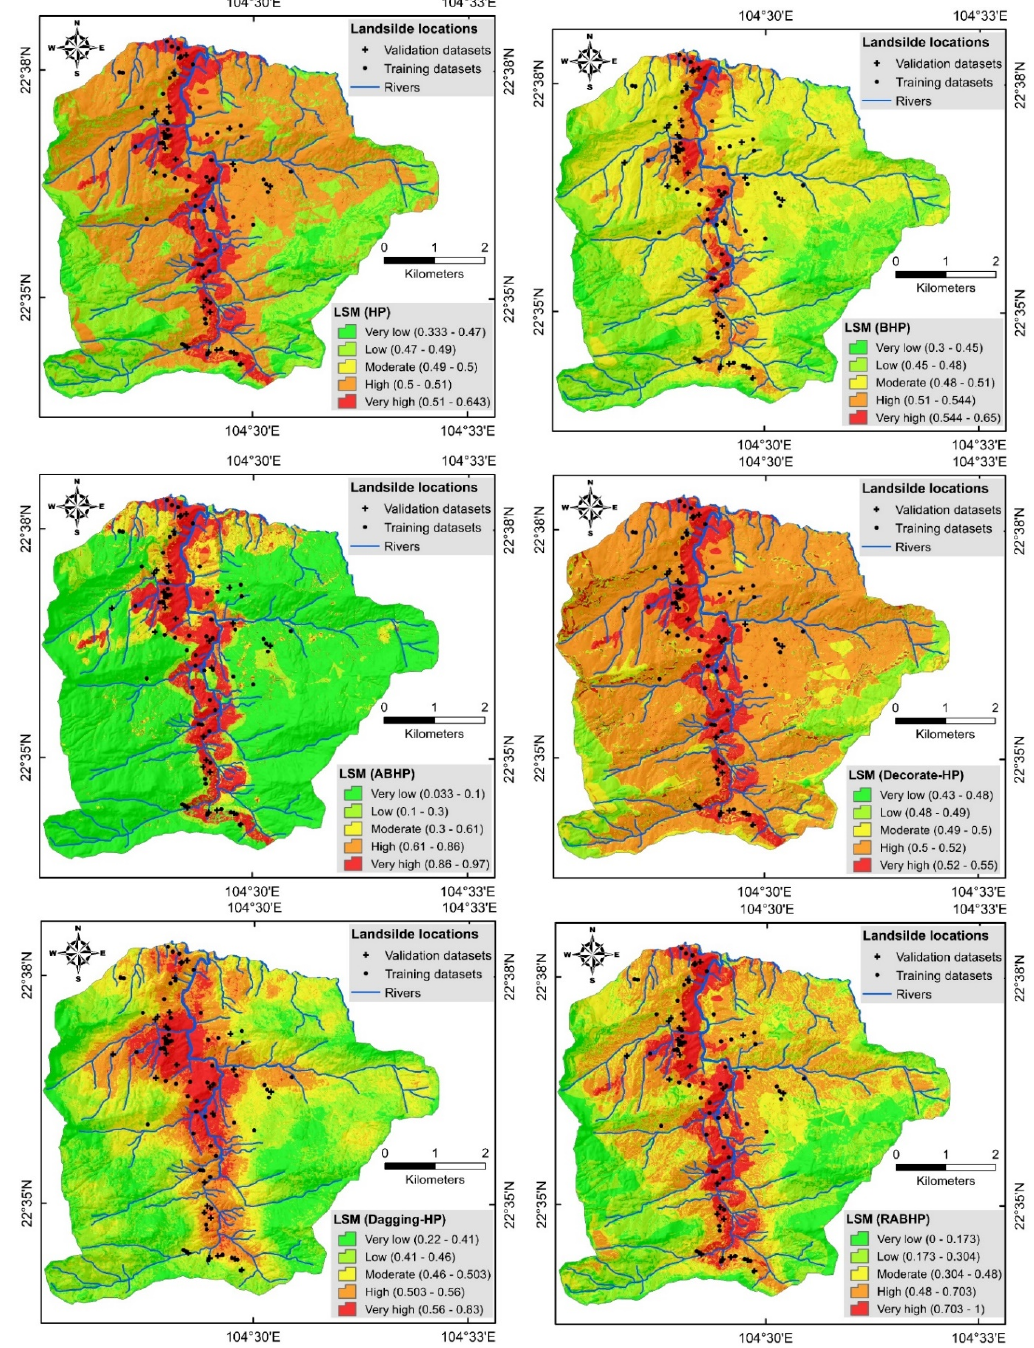
Figure 7. Landslide susceptibility maps (LSM) generated for the Nam Dan commune. The frequency ratio analysis of the susceptibility maps revealed that the map derived from the ABHP model was the most trustworthy map in comparison with the other maps derived from the other five models. The percentage and frequency of landslide pixels in the ABHP maps for the high and very high susceptibility classes were higher than the other models (Figure 8b,c).